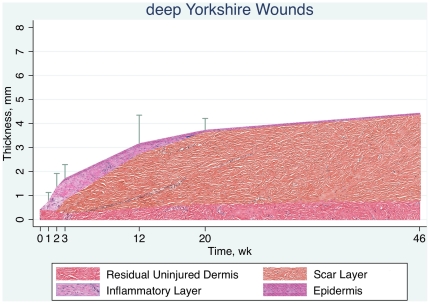
Schematic time course of wound thickness in deep Yorkshire wounds.The granulation tissue layer and the scar layer in the Yorkshire breed are much thinner than in the Duroc breed.